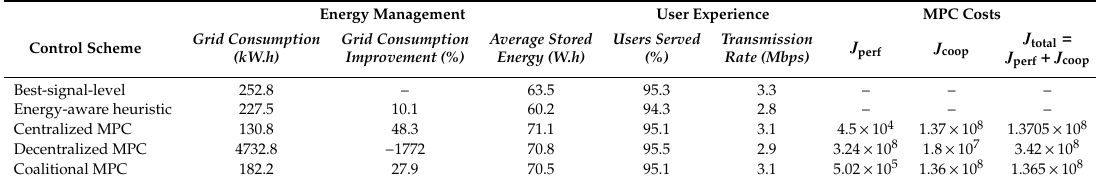
Table 3. Numerical results in the 37-BS